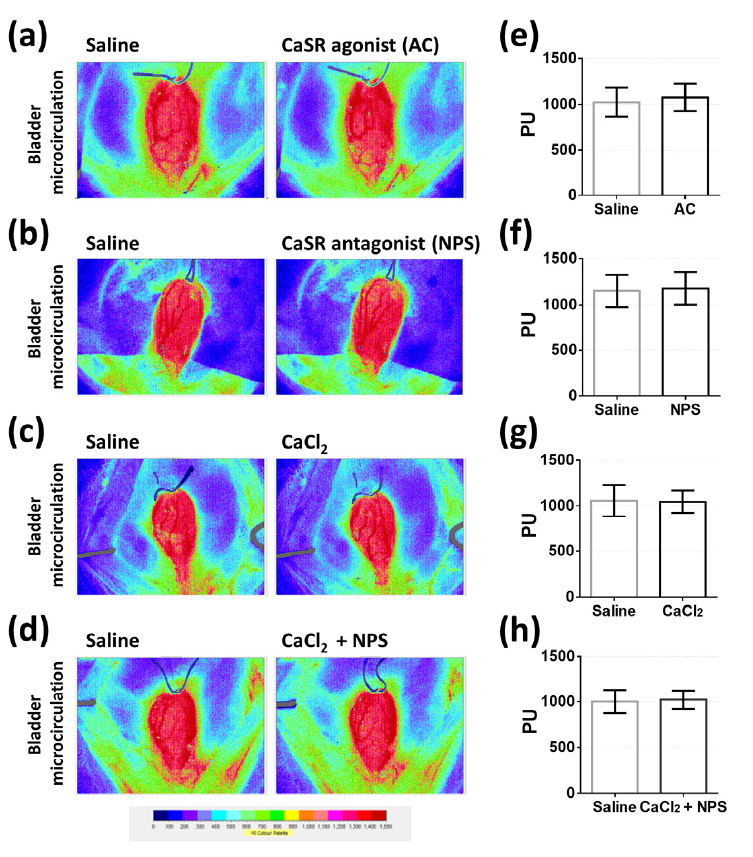
Figure 8. The evaluation of bladder microcirculation before and after intravesical infusion of CaSR agonist (AC), CaSR antagonist (NPS), CaCl 2 , and CaCl 2 containing NPS. Images of bladder microcirculation before (saline) and after intravesical infusion of 1 mM AC ( a ), 1 mM NPS ( b ), 20 mM CaCl 2 ( c ), and 20 mM CaCl 2 containing 1 mM NPS (CaCl 2 + NPS) ( d ). The statistical analysis of bladder perfusion unit (PU) before (saline) and after intravesical infusion of AC ( e ), NPS ( f ), CaCl 2 ( g ), and CaCl 2 containing NPS (CaCl 2 + NPS) ( h ) (Two-tailed paired Student’s t -test, n = 5 for each group).